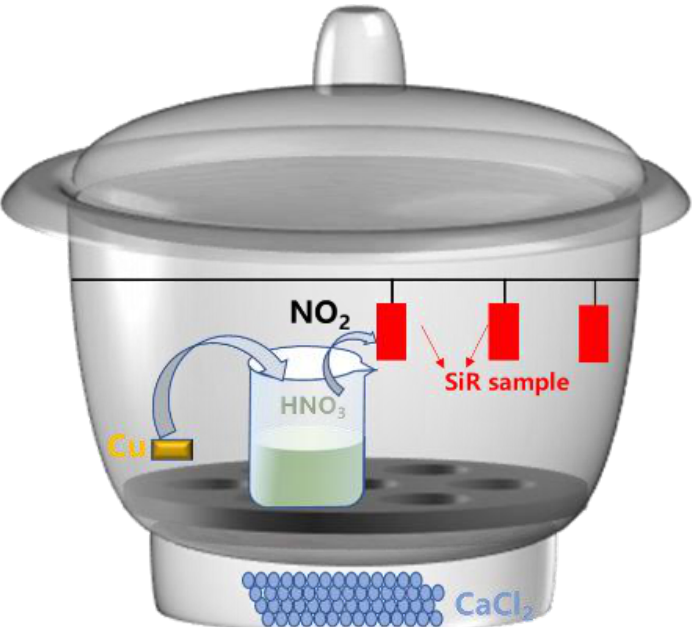
Figure 1. The schematic diagram of experimental device. NO 2 was produced by the reaction of a copper sheet (Cu) with concentrated nitric acid (HNO 3 ) and corroded silicone rubber (SiR) sample.